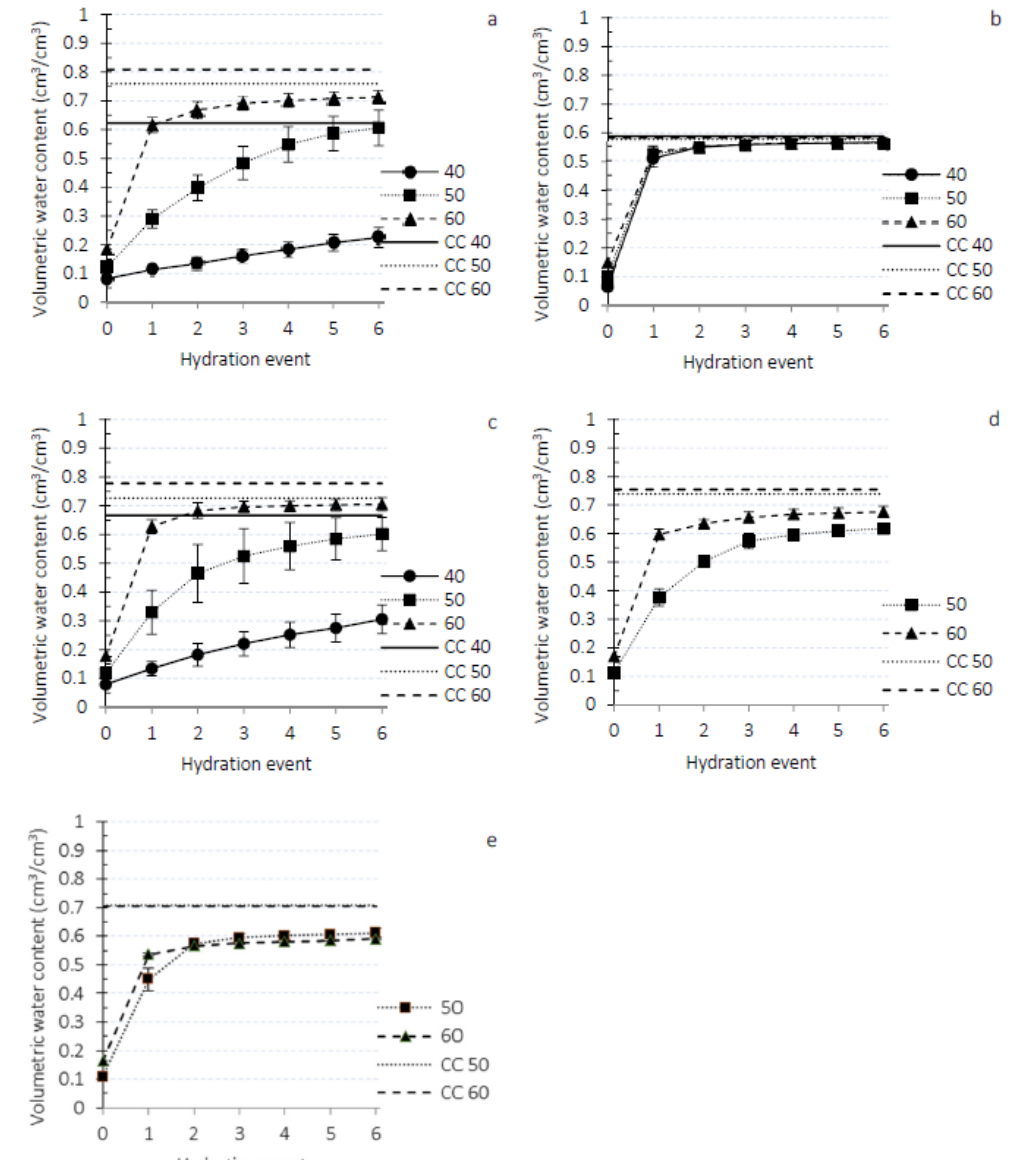
Figure 1. Cumulated water capture during six successive irrigation events and container capacity (CCMC) for peat ( a ), wood fiber ( b ) and 80:20 ( c ), 60:40 ( d ), 40:60 ( e ) peat:wood fiber mixes depending on initial moisture contents (MC = 40, 50, 60% w / w ).